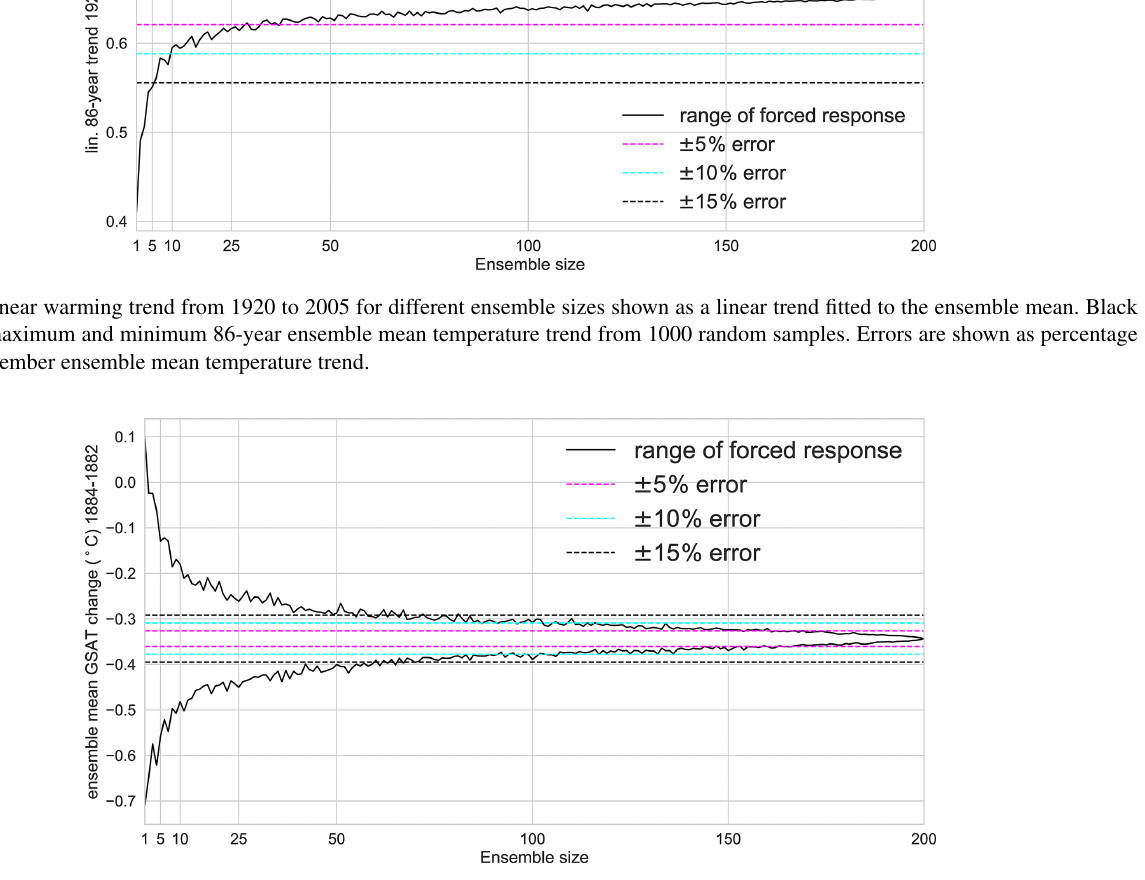
Figure 6. GSAT cooling after Krakatoa eruption for different ensemble sizes shown as the ensemble mean temperature difference be- tween 1882 and 1884. Black lines show maximum and minimum temperature response from 1000 random samples. Errors are shown as percentage of the 200-member ensemble mean temperature